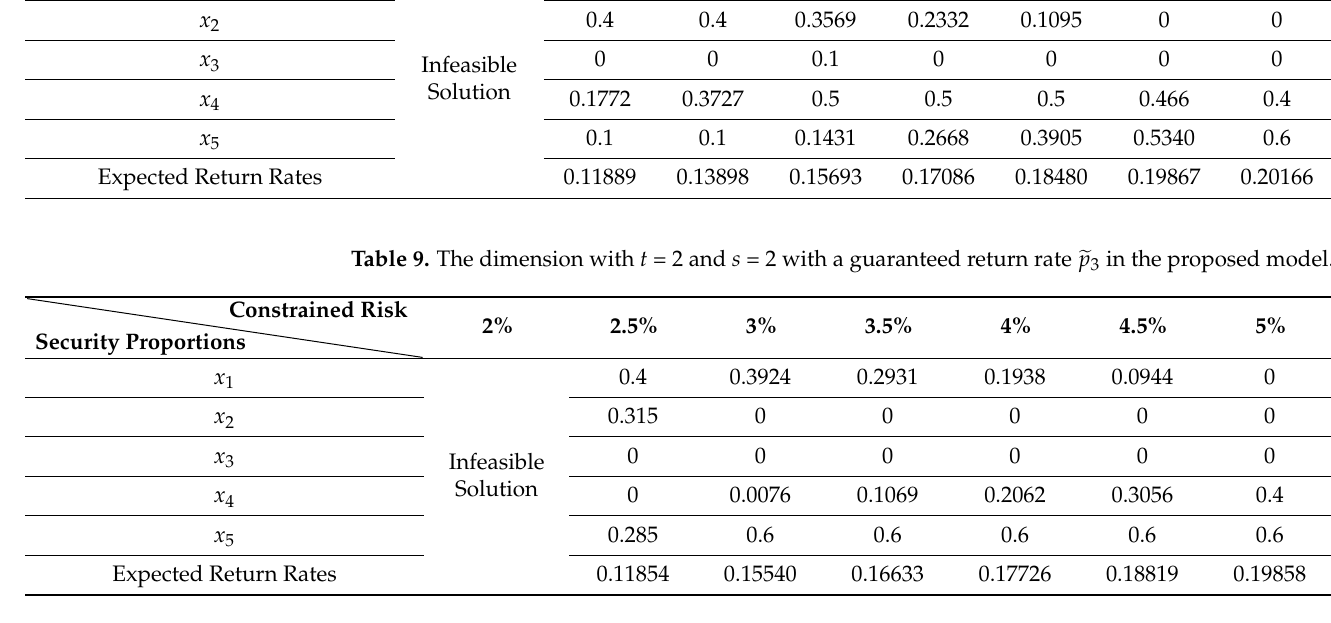
Table 10. The dimension with t = 3 and s = 3 with a guaranteed return rate (cid:101) p 1 in the proposed